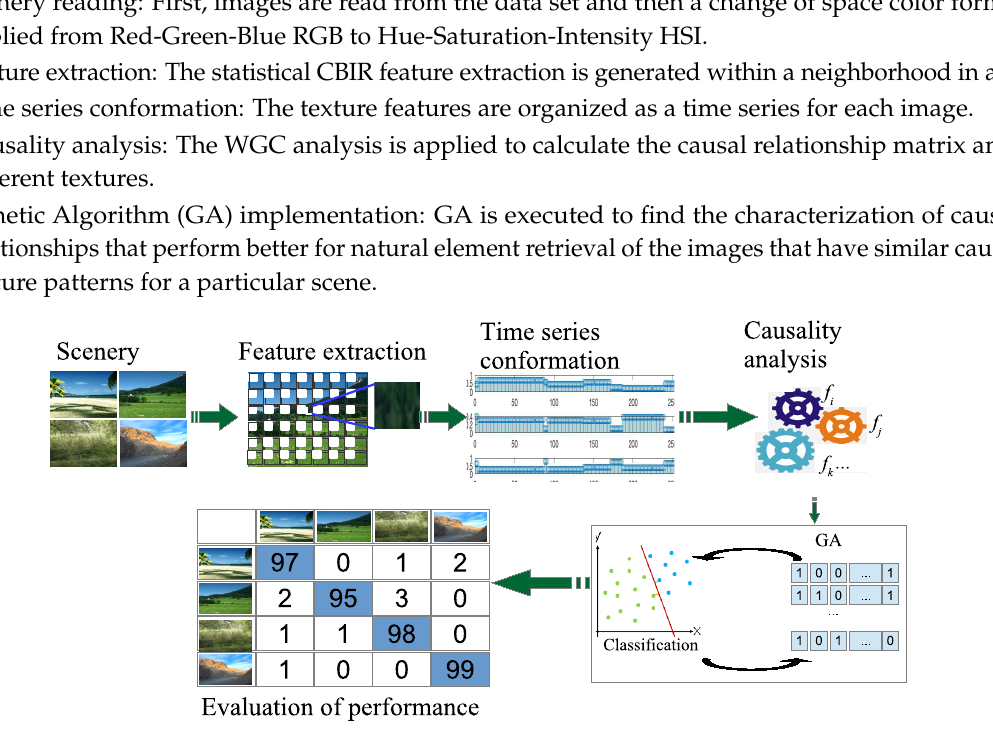
Figure 1. Proposed general methodology applied for image